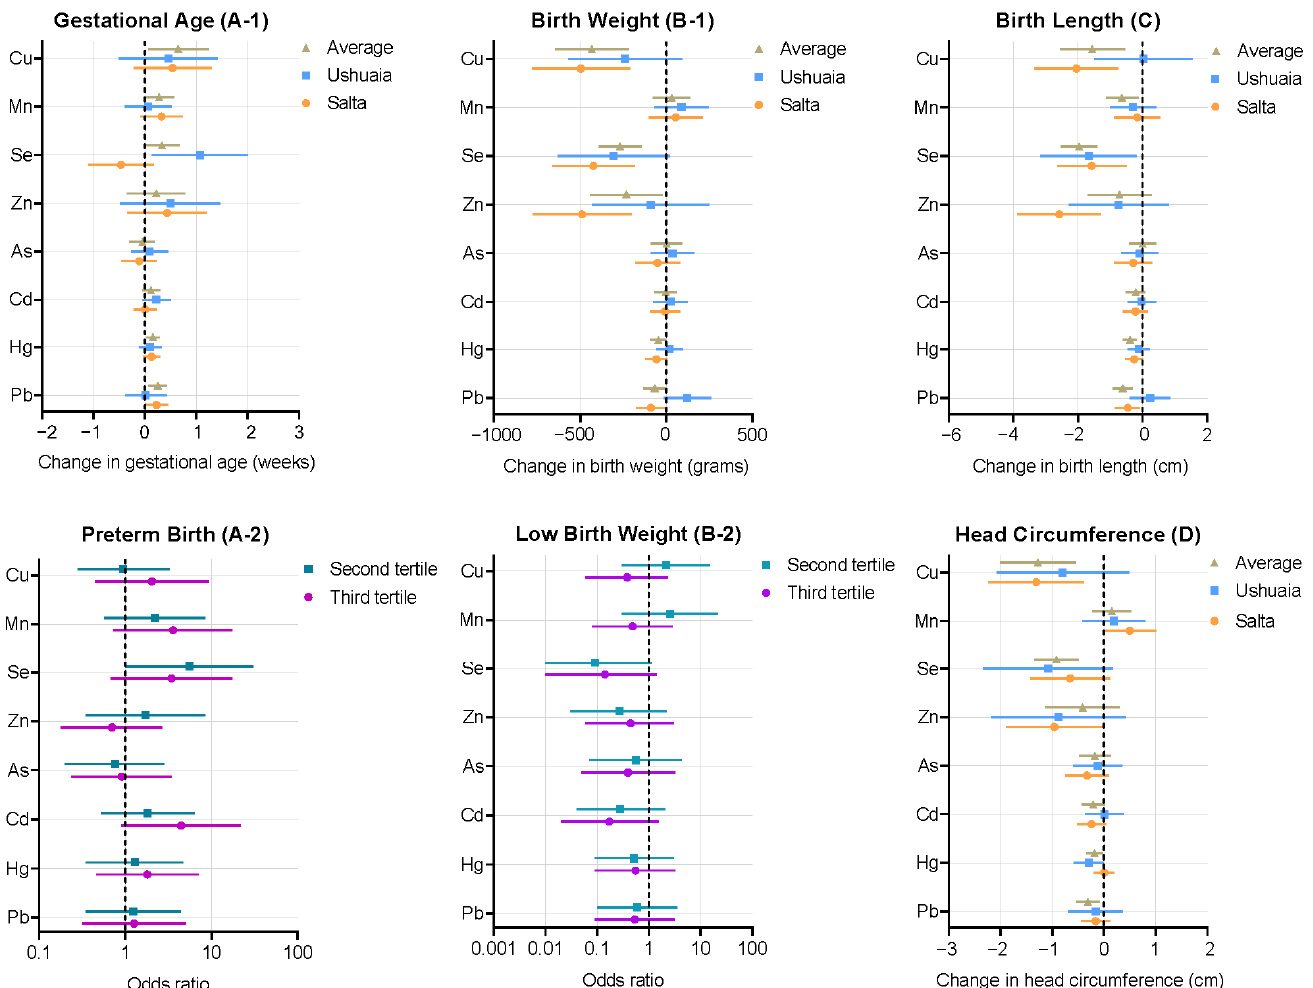
Figure 2. Changes in the birth outcomes associated with overall and regional specific blood elements concentrations ( A-1 , B-1 , C , D ). The results of logistic regression analyses show the relationships between tertile of maternal elements levels and preterm birth and low birth weight ( A-2 , B-2 ). The elements concentrations were natural logarithms transformed. Effect estimates presented as changes in the gestational age, birth weight, length, and head circumference for one ln-unit change in the elements. The odds ratios of the logistic regression analyses are displayed with 95% confidence interval, with the first tertile of the elements levels as the reference. All models were adjusted for maternal age, parity, pre-pregnancy BMI, smoking, and education. In addition, birth weight and birth length were added into the gestational age regression model ( A-1 ), and gestational age was introduced into the birth weight ( B-1 ), length ( C ), and head circumference ( D ) regression models. Low birth weight was introduced into preterm birth ( A-2 ) and preterm birth was introduced into low birth weight model ( B-2 ). Abbreviations: As, arsenic; Cd, cadmium; Cu, copper; Hg, mercury; Mn, manganese; Pb, lead; Se, selenium; and Zn, zinc.